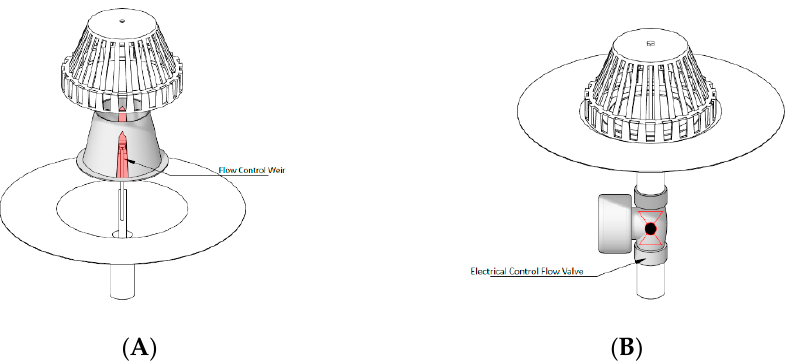
Figure 3. Flow control drain: ( A ) Passively Controlled System (PCS) and ( B ) Actively Controlled System (ACS).